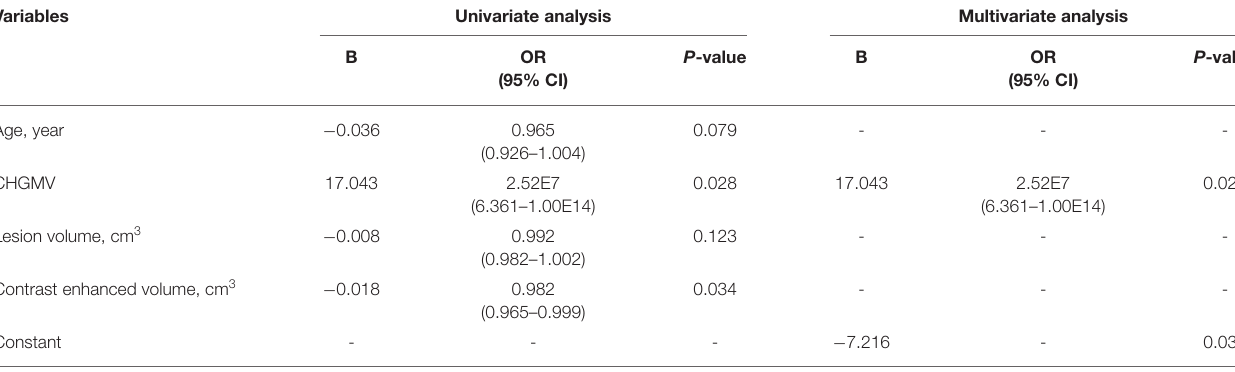
TABLE 2 | Univariate and multivariate logistic regression analysis of variables to predict IDH1 mutation.